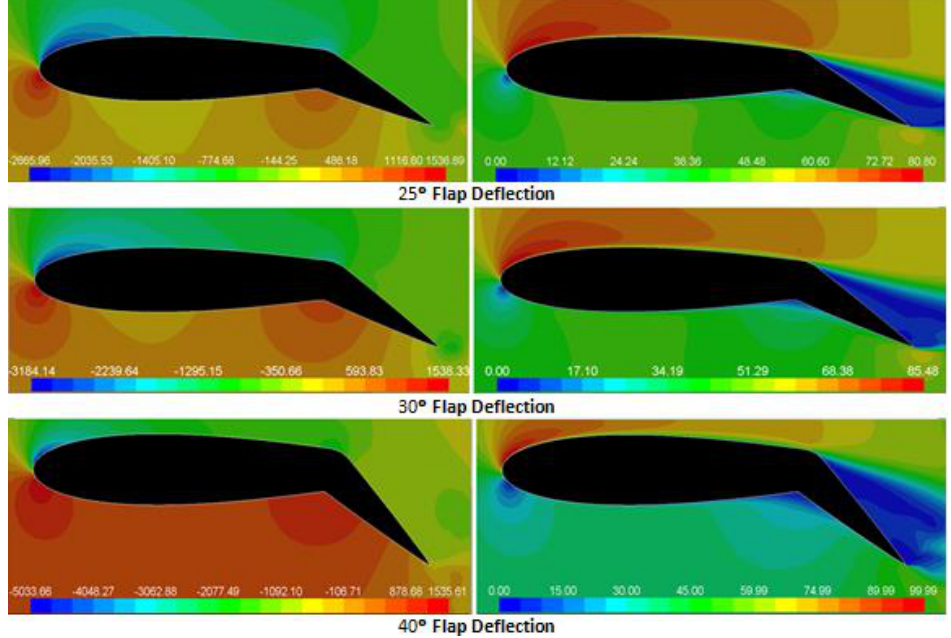
Figure 15. Static pressure and velocity magnitude contours around the NACA 0015 flapped airfoil at an angle of attack of 0° for different flap deflections.